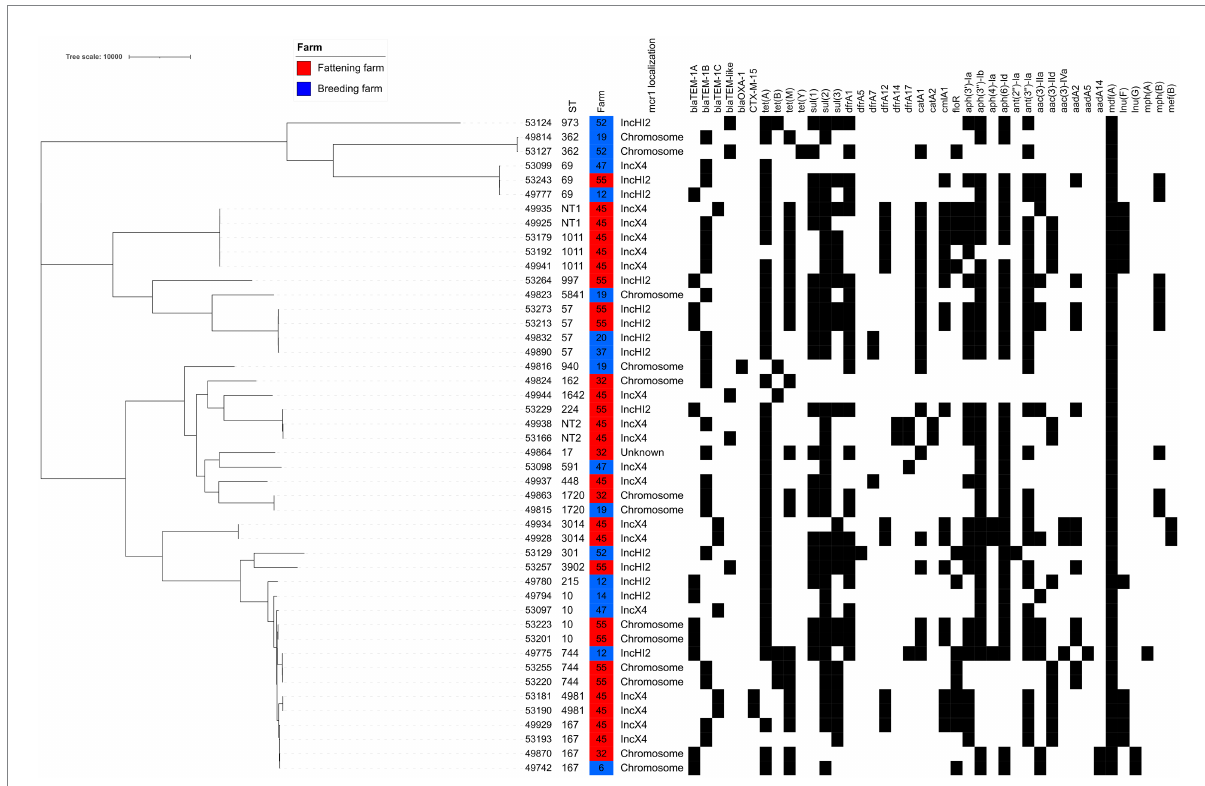
FIGURE 2 SNP-based phylogenetic tree of all mcr-1 -positive E. coli from goat. The presence of antibiotic-resistance genes is shown by a black square. TEM- like variants are detailed in Supplementary Table